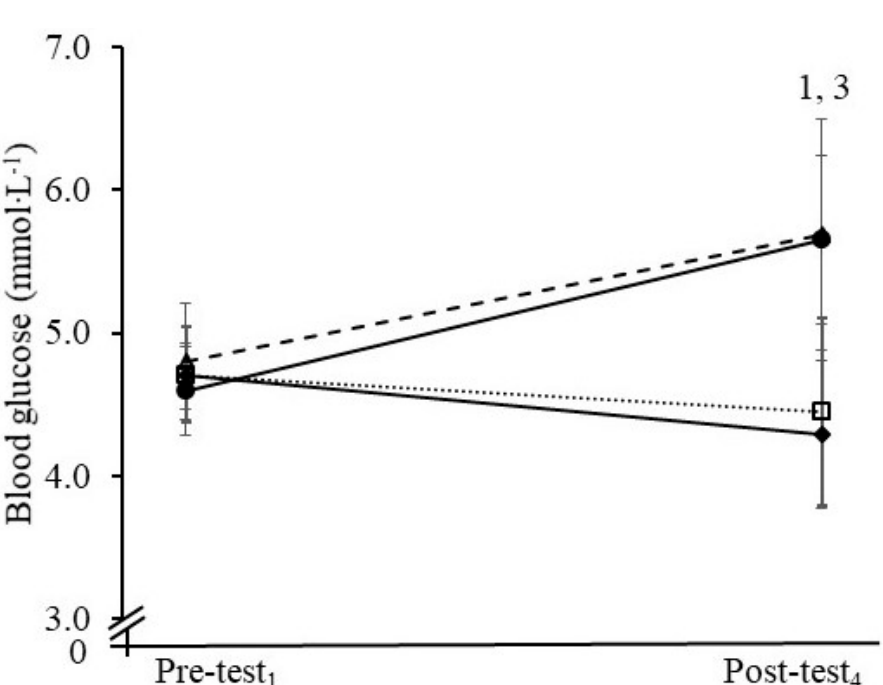
Figure 2. Blood glucose concentrations at the start (Pre-test 1 ) and end of the morning (Post-test 4 ) in the fasted and seden- tary (F-S, ♦ ), breakfast and sedentary (B-S, ∆ ), fasted and exercise (F-E, □ ), and breakfast and exercise (B-E, ● ) groups. 1 Change in B-E > than F-S over the morning, p < 0.05. 3 Change in B-E > than F-E over the morning, p < 0.05. Error bar: